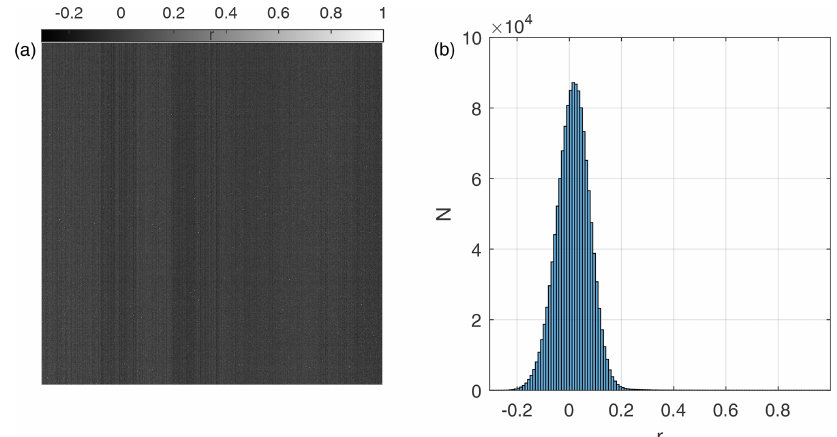
Figure 5. Correlation coefficient of pixel signal at t 1 with temperature for each pixel (a) and its frequency distribution (b) .